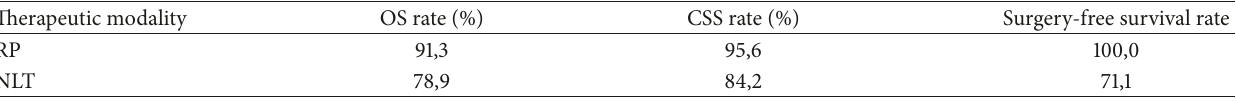
in the RP group compared to NLT group (55% versus 21%)